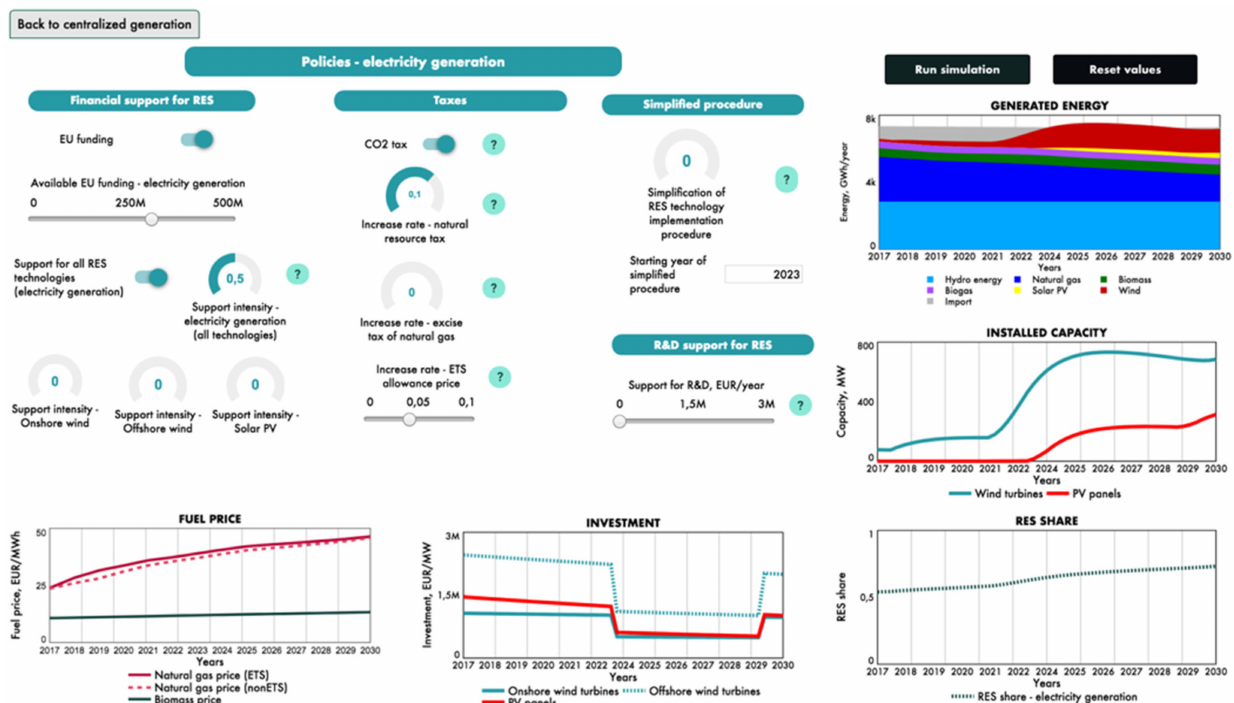
Figure A5. The second page of Internet-based model interface for energy supply subsector policy tools.